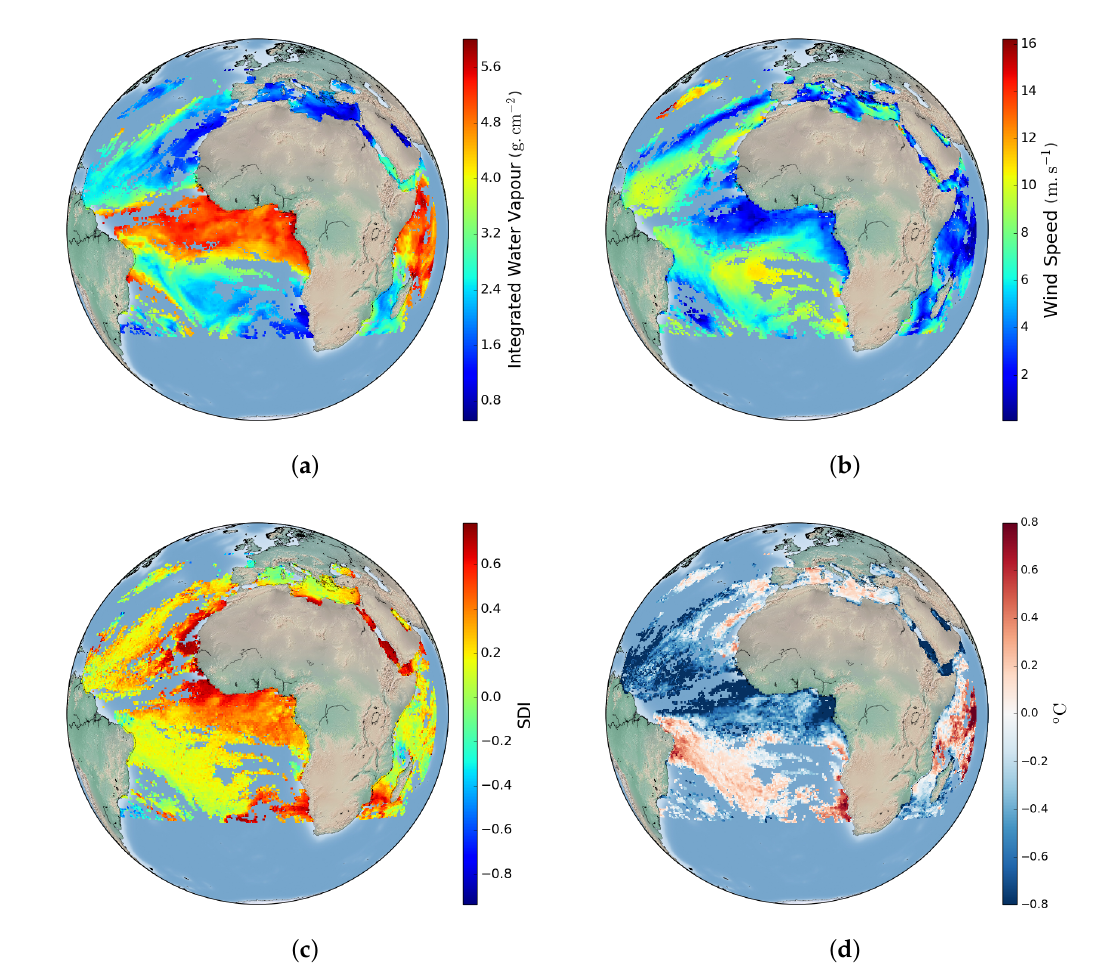
Figure 6. ( a ) Integrated water vapour; ( b ) Wind speed; ( c ) Saharan Dust Index; ( d ) ∆ SST predicted by random forest model (30 April 2015 at 12